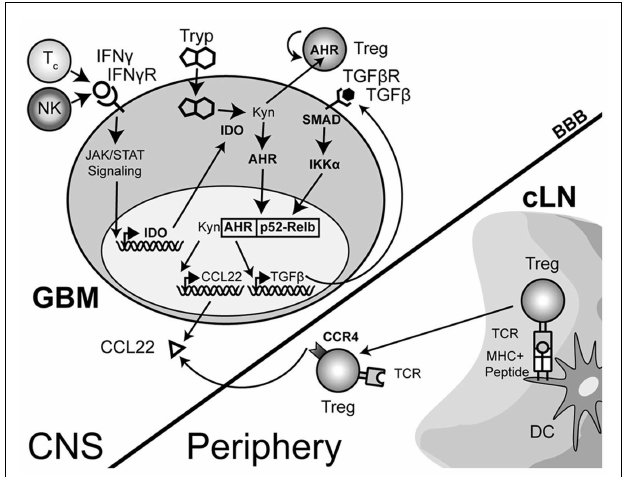
FIGURE 3 |A theoretical model depicting the process of regulatoryT cell (Treg) recruitment and expansion in brain tumors .The interaction of Treg with cervical (draining) lymph node (cLN)-resident dendritic cells (DC) through theT cell receptor (TCR)-peptide/major histocompatibility complex (MHC) II activates and epigenetically stabilizes the expression of CCR4-expressingTreg.These recently stimulatedTreg then emigrate from the cLN into the circulation where they can respond to the gradient of the Treg-recruiting chemokine, CCL22, being produced by the glioma.Within the glioma, innate natural killer (NK) cells that initially respond to the tissue disruption and inflammatory signals produced by the tumor are later joined by antigen-specific CD8 + cytotoxicT cells (Tc); both of which produce the pro-inflammatory cytokine, interferon-gamma (IFN- γ ).This cytokine acts on the glioma-expressed, IFN- γ R, resulting in downstream Janus-kinase/signal transducer and activator of transcription (JAK/STAT) activity